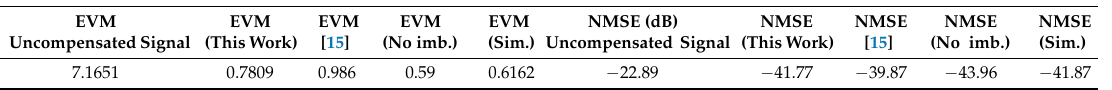
Table 4. NMSE and EVM for 1 MHz 16 QAM signal using experimental data and comparison with